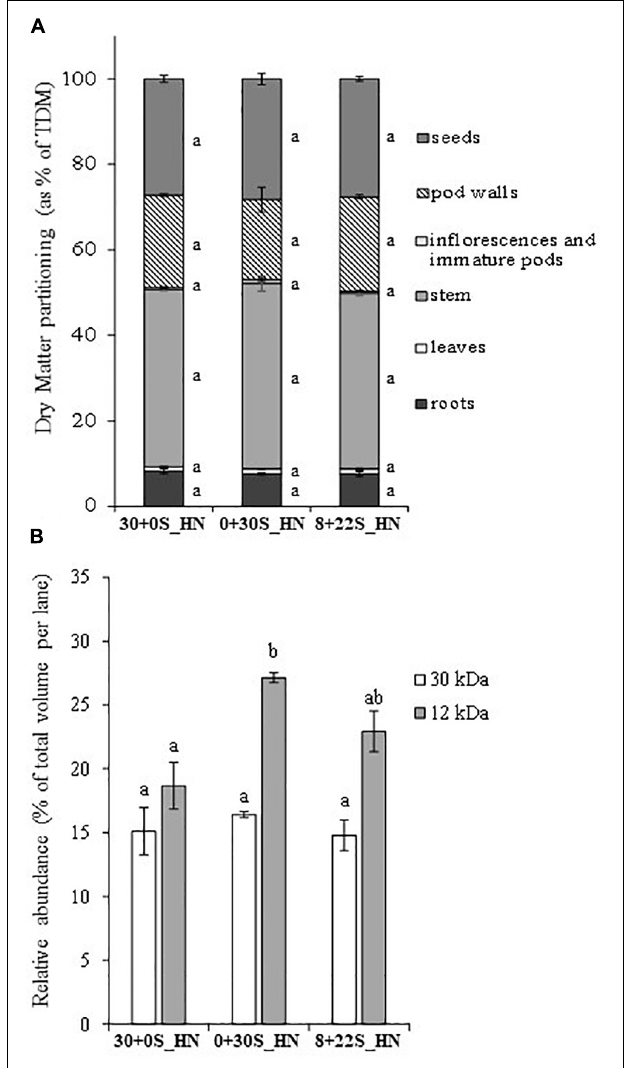
FIGURE 5 | DM partitioning (as % of total DM in plant) (A) and relative abundance (% of total volume per lane) of a 30-kDa protein (cruciferin, S-poor protein) and a 12-kDa protein (napin, S-rich protein) in mature seeds (B) of plants grown under 30+0S_HN, 0+30S_HN, and 8+22S_HN conditions. Vertical bars indicate ± SE of the mean ( n = 5, B; n = 4 for 30+0S_HN). Different letters indicate that mean values are significantly